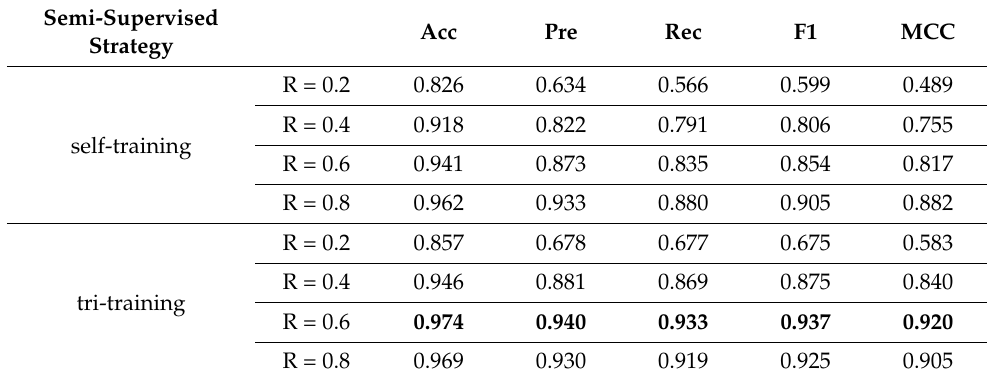
Table 5. Comparison of self-training and tri-training semi-supervised learning strategies. Semi-Supervised Strategy